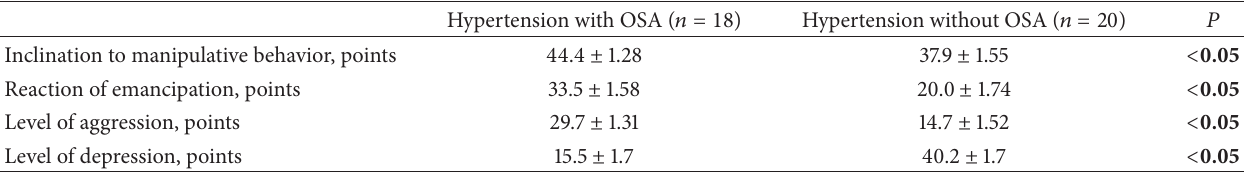
Table 3: Neurobehavioral characteristics of examined patients according to absence or presence of OSA.